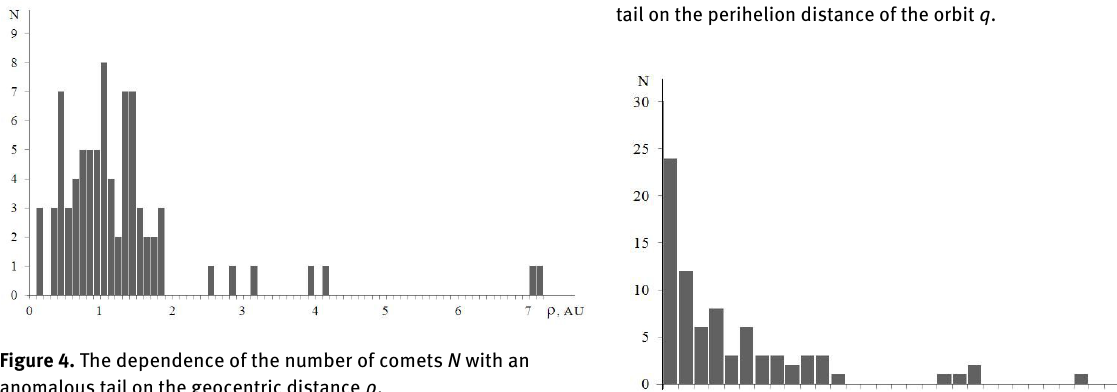
Figure 5. Dependence of the number of comets N with an anomalous tail on the perihelion distance of the orbit q .